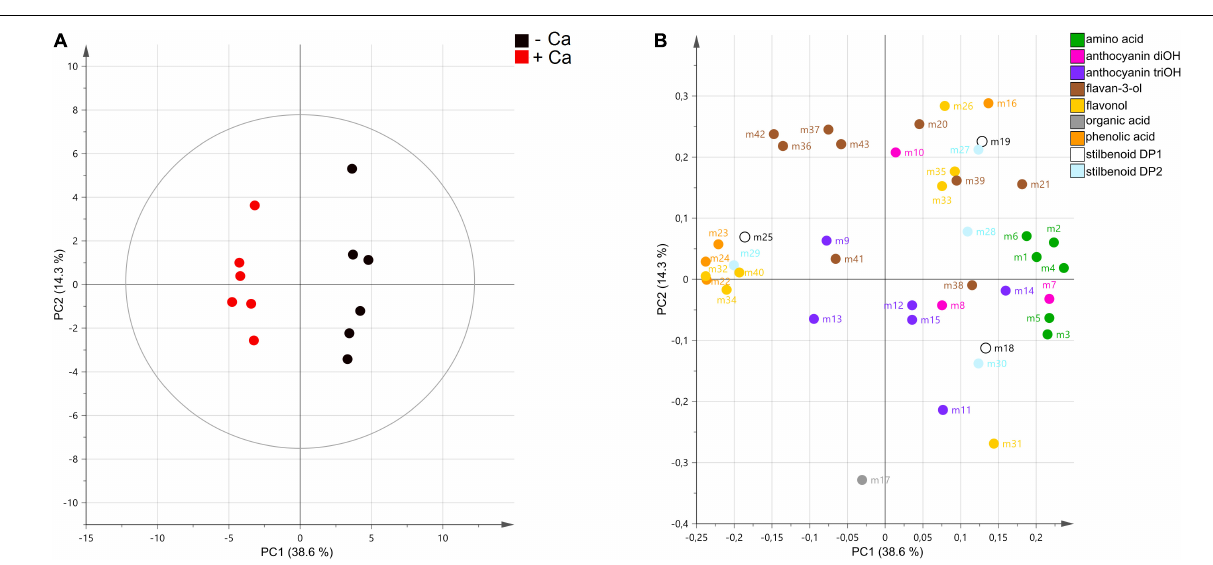
FIGURE 3 | Unsupervised classification using the principal component analysis on metabolomic data from grape berries from vines cv. Loureiro treated with Ca (+ Ca) or without treatment (– Ca) ( n = 6). Variables in the score plot (A) were colored according to the treatment, and variables in loading plot (B) were colored according to the metabolic class. Numbers indicate the ID of metabolites, as follows: L-proline (m1), L-leucine (m2), L-isoleucine (m3), L-phenylalanine (m4), L-tyrosine (m5), L-tryptophan (m6), cyanidin-3- O -glucoside (m7), peonidin-3- O -glucoside (m8), delphinidin-3- O -glucoside (m9), cyanidin-3- O -(6- O -acetyl)-glucoside (m10), malvidin-3- O -glucoside (m11), malvidin-3- O -(6- O -acetyl)-glucoside (m12), petunidin-3- O -(6- p -coumaroyl)-glucoside (m13), malvidin-3- O -(6- p -coumaroyl)-glucoside (m14), malvidin-3,5- O -diglucoside (m15), gallic acid (m16), citric acid (m17), E -resveratrol (m18), E -piceatannol (m19), catechin (m20), epicatechin (m21), coutaric acid (m22), caftaric acid (m23), fertaric acid (m24), E -piceid (m25), kaempferol-3- O -glucoside (m26), pallidol (m27), E - ε -viniferin (m28), E - ω -viniferin (m29), E - δ -viniferin (m30), quercetin-3- O -glucoside (m31), quercetin-3- O -glucuronide (m32), myricetin-hexoside 1 (m33), myricetin-hexoside 2 (m34), quercetin derivative (m35), procyanidin B1 (m36), procyanidin B2 (m37), procyanidin B3 (m38), procyanidin B4 (m39), kaempferol-3- O -rutinoside (40), procyanidin gallate (41), procyanidin trimer 1 (42), and procyanidin trimer 2